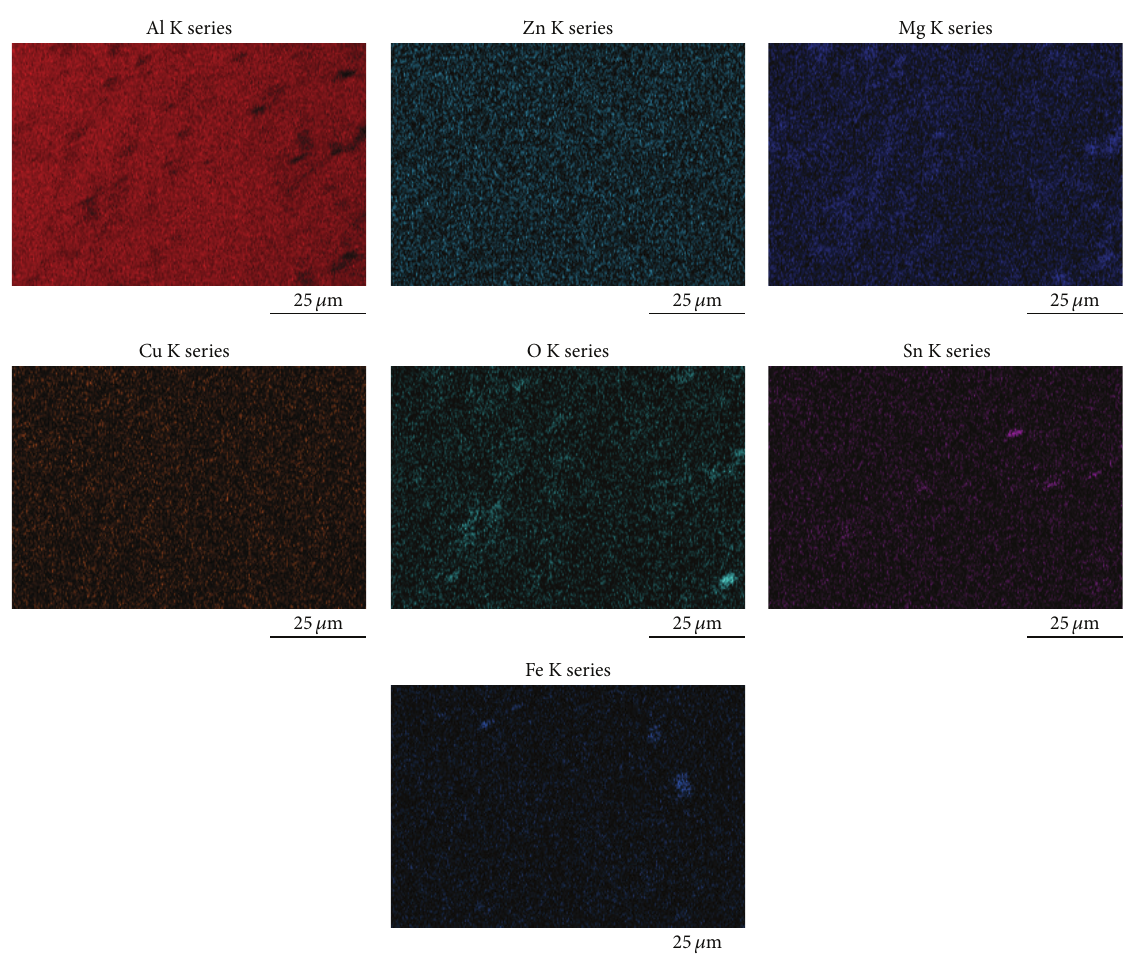
Figure 10: Elemental distribution analysis by EDS of Alumix 431D after T6 heat treatment starting with Al, Zn, and Cu which homogenously dispersed throughout the surface and Mg, O, Fe, and Sn seem to be concentrated at certain places on the surface.